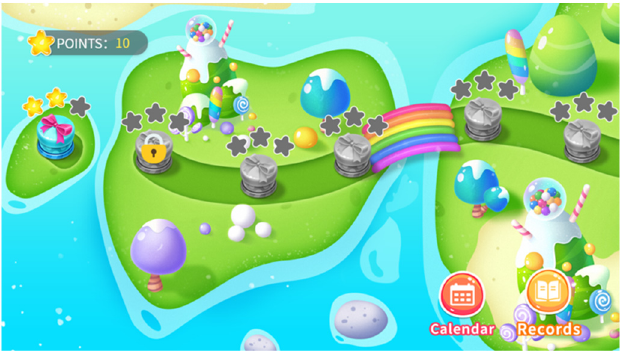
Figure 1. Screenshot of daily challenges within CareMom.